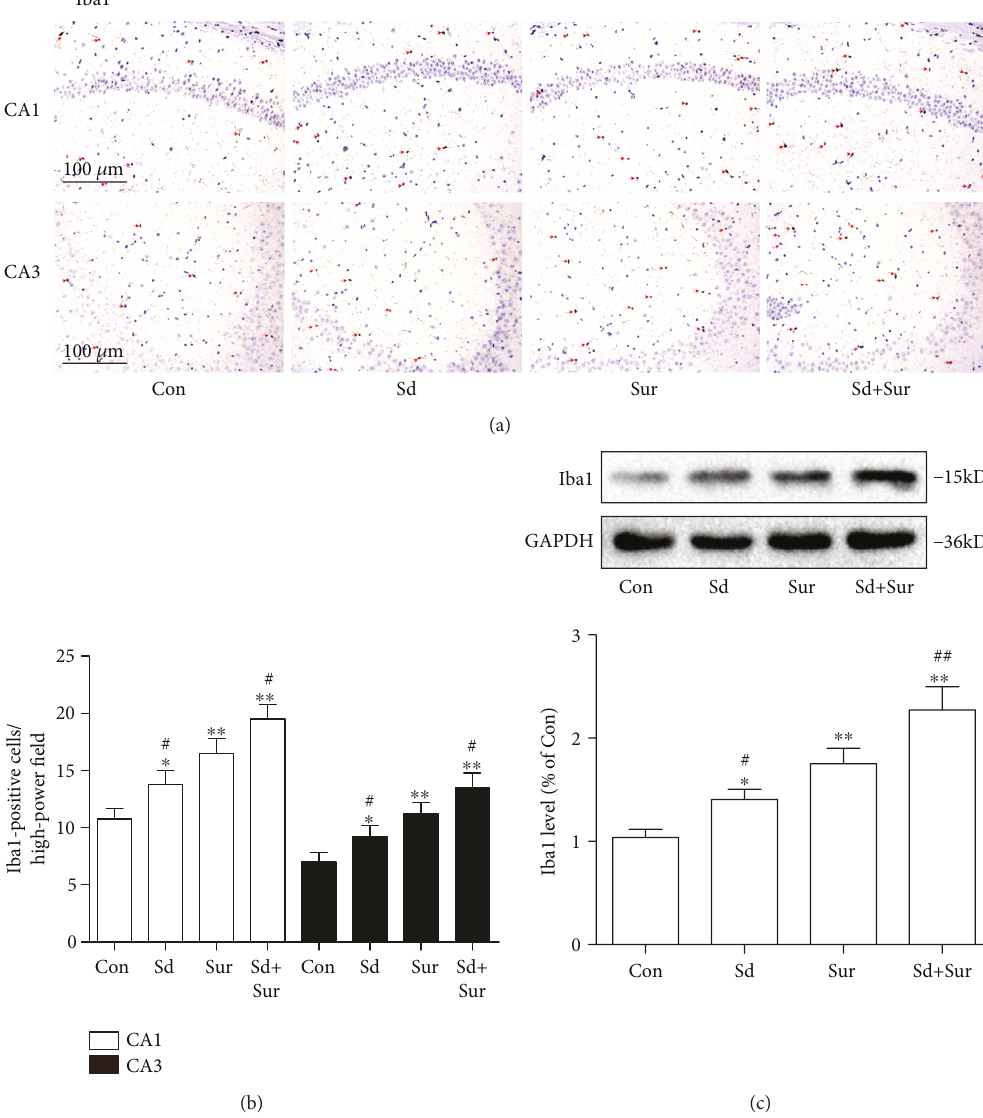
Figure 4: Preoperative sleep disturbance enhanced microglial activation in the hippocampus induced by the tibial surgery. (a) Representative immunohistochemistry images of microglia (red arrows) in areas CA1 and CA3 of the hippocampus based on staining with an anti-Iba1 antibody. Scale bar: 100 μ m. (b) Quanti fi cation of Iba1-positive cells in areas CA1 and CA3 of the hippocampus. (c) Expression levels of Iba1 protein in the hippocampus. The data are presented as the mean ± sem ( n = 4 ). ∗ P < 0 05 and ∗∗ P < 0 01 vs. the Con group; # P < 0 05 and ## P < 0 01 vs. the Sur